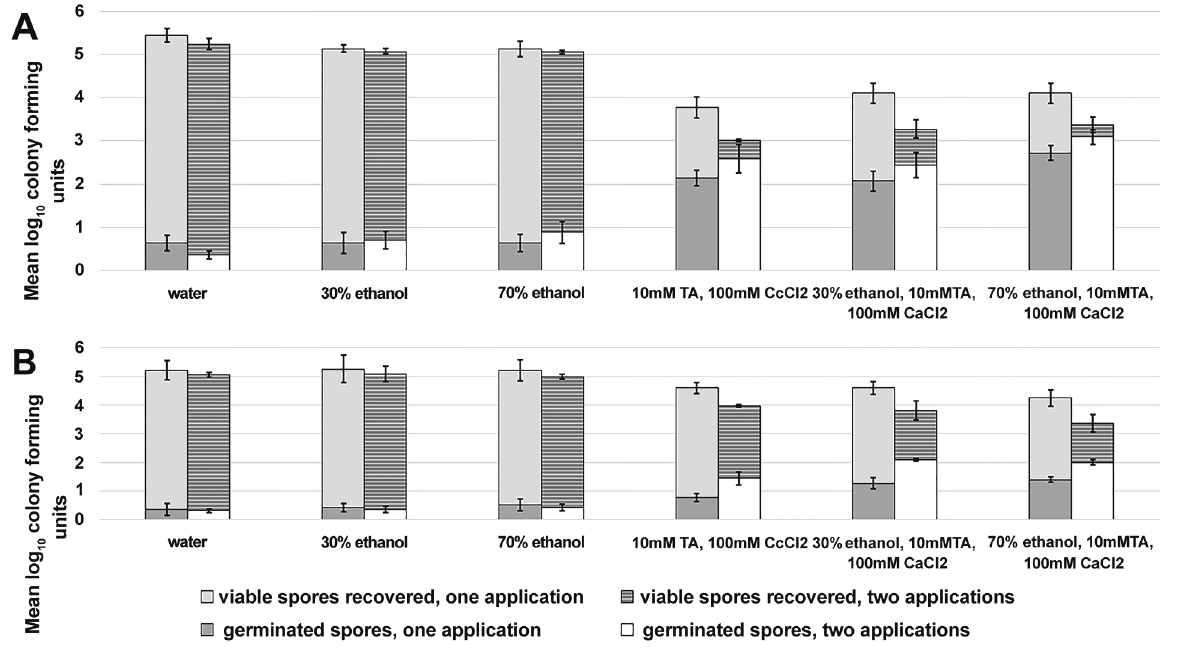
Figure 4. A second application of germinant solution enhances the reduction of Clostridium difficile spores on environmental surfaces. Two sets of stainless steel carriers (1cm 2 ) were placed on a hospital bedside table and inoculated with 6 log colony forming units (CFU) of C. difficile VA17 (A) and VA11 10 (B). Both sets of carriers were sprayed until uniformly wet with test solutions and allowed to air dry. After 24 hours of incubation at room temperature, 1 set of carriers was collected and the log CFU of viable and 10 germinated spores was determined. The second set of carriers was exposed to another uniform application of test solutions and allowed to air dry, then 24 hours post application the spores were recovered from the carriers and the log CFU of viable and germinated spores was determined. The means of triplicate data 10 from 2 experiments are presented (N = 6). Error bars indicate standard